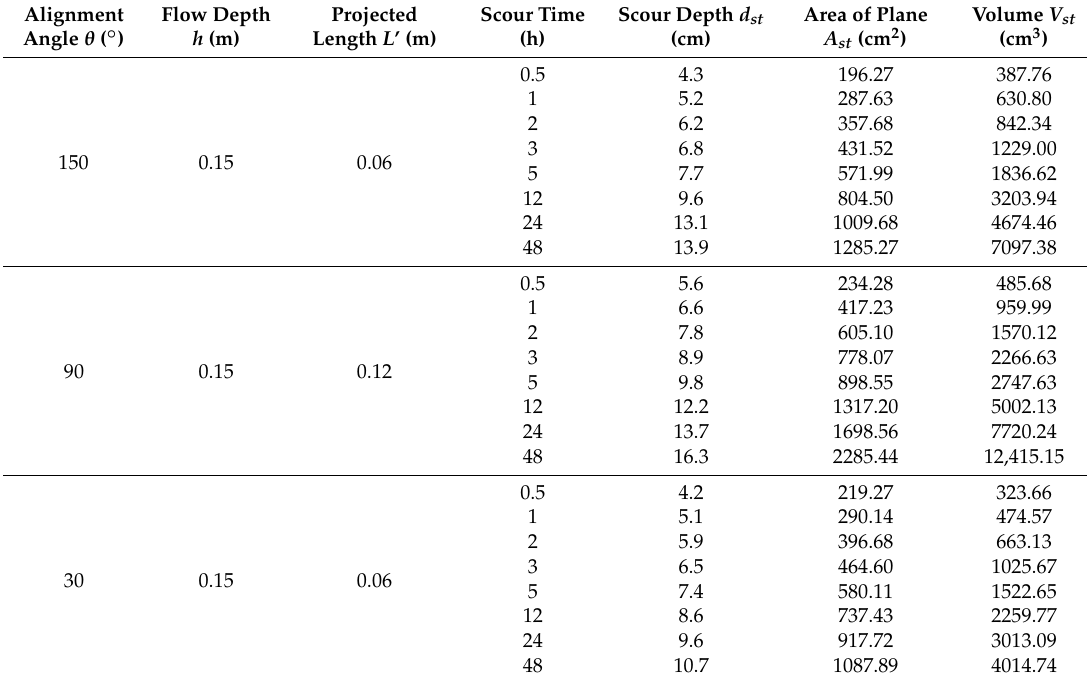
Table 1. Flow conditions and experimental results.